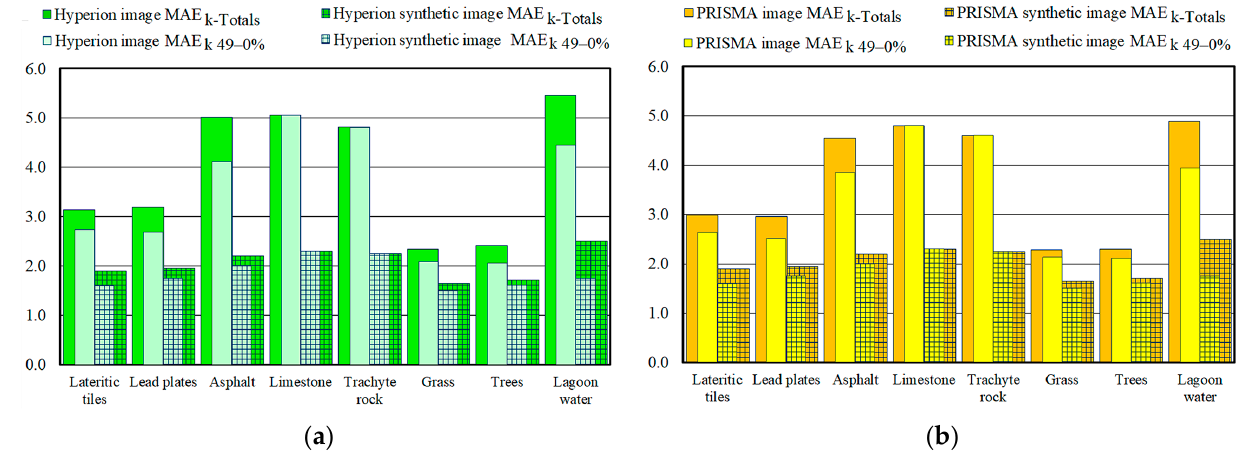
Figure 8. The comparison of the MAE k values (MAE k-49–0% values are superimposed on the MAE kTotals values) evaluated from real and synthetic (square pattern) images: ( a ) the values obtained from Hyperion images; ( b ) the values obtained from PRISMA images.